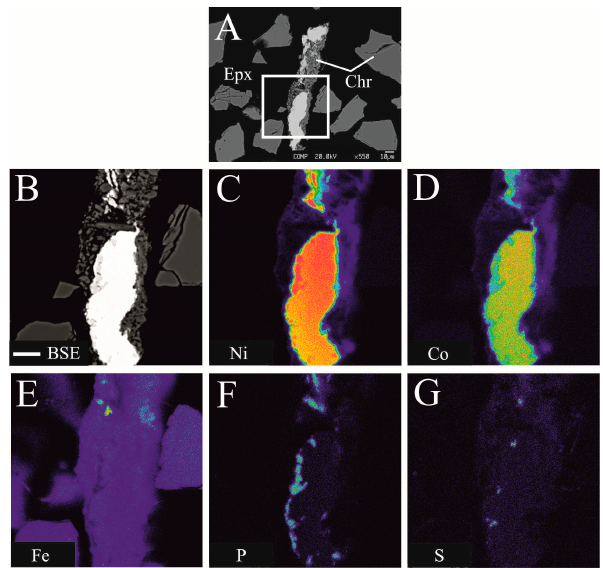
Figure 5. BSE images from heavy concentrate of the Othrys chromitite showing a brecciated texture in a similar way to those reported in Figure 2A. Enlargement of the grain of Figure 5 A , displaying the brecciated chromite in contact with awaruite containing small blebs of pentlandite and associated with a Ni-phosphide ( B ). X-ray elemental distribution map for Ni ( C ), Co ( D ), Fe ( E ), P ( F ), S ( G ). Abbreviations: Epx = epoxy, Chr = chromite. Scale bar in Figure B is 10 μ m.